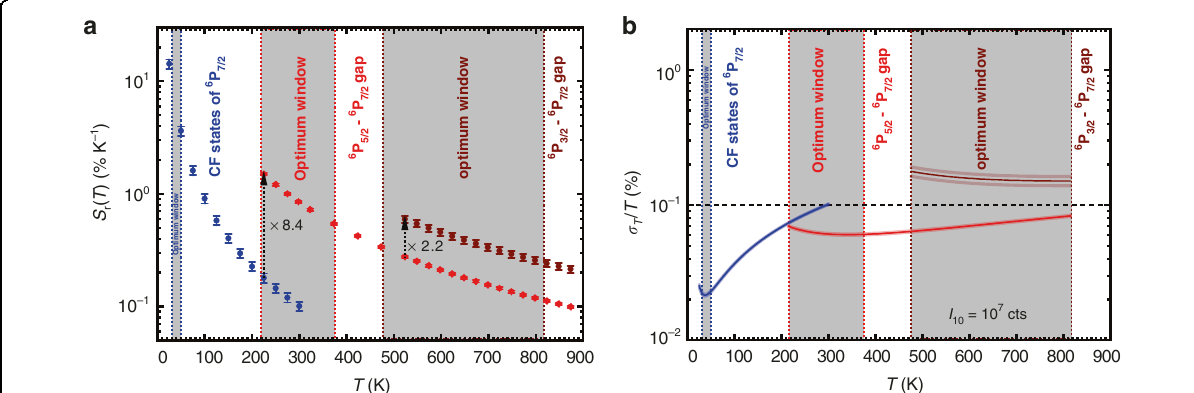
Fig. 4 Assessment of the optimum performance of a wide-range multilevel luminescent Boltzmann thermometer based on Gd 3 + in YAB: Pr 3 + , Gd 3 + . a Plot of the relative sensitivities S r of the different temperature measures and their improvement upon thermodynamically guided change of the respective energy gap of the excited levels of Gd 3 + used for temperature sensing. b Overall theoretical relative temperature uncertainty of the different energy gaps assuming a constant integrated intensity measure of I 10 = 10 7 counts of the selected lowest energetic emission. A relative temperature uncertainty of 0.1% is desirable because it allows the measurement of temperatures below 1000 K with a statistical error of ±1 K. The shaded areas indicate the statistical fl uctuations in the relative temperature